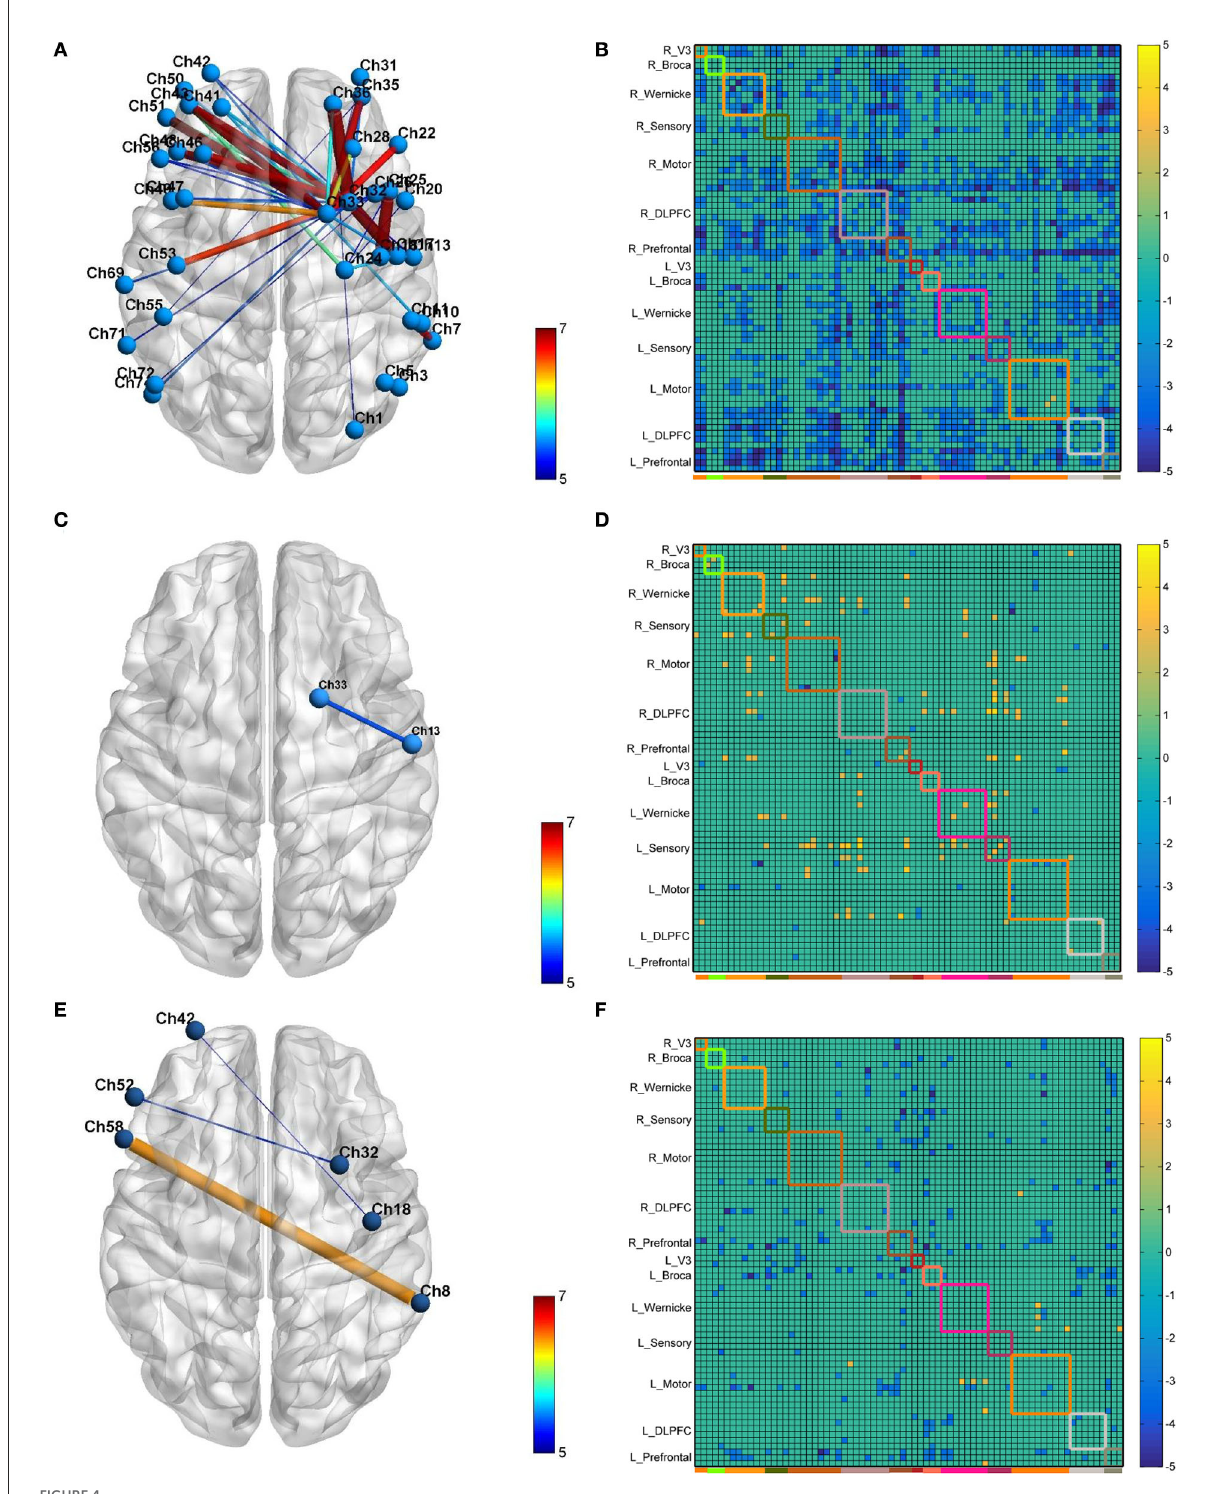
FIGURE4 The 3D brain visualization of the difference in the connectivity after CB-SMA (A) protocol, CB-M1 protocol (C) , and CB-single (E) . The FC Matrix of different connections between post- and pre-iTBS intervention in CB-SMA group (B) , CB-M1 group (D) and CB-single (F) . Significant connections (p < 0.05, FDR corrected) after paired t -test are colored contrast to background color according to T -values. Subnets and within connections are highlighted by